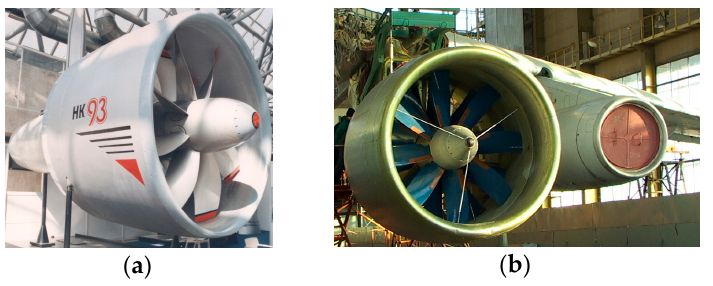
Figure 1. IL-76 with NK-93. ( a ) Side view; ( b ) Front view.